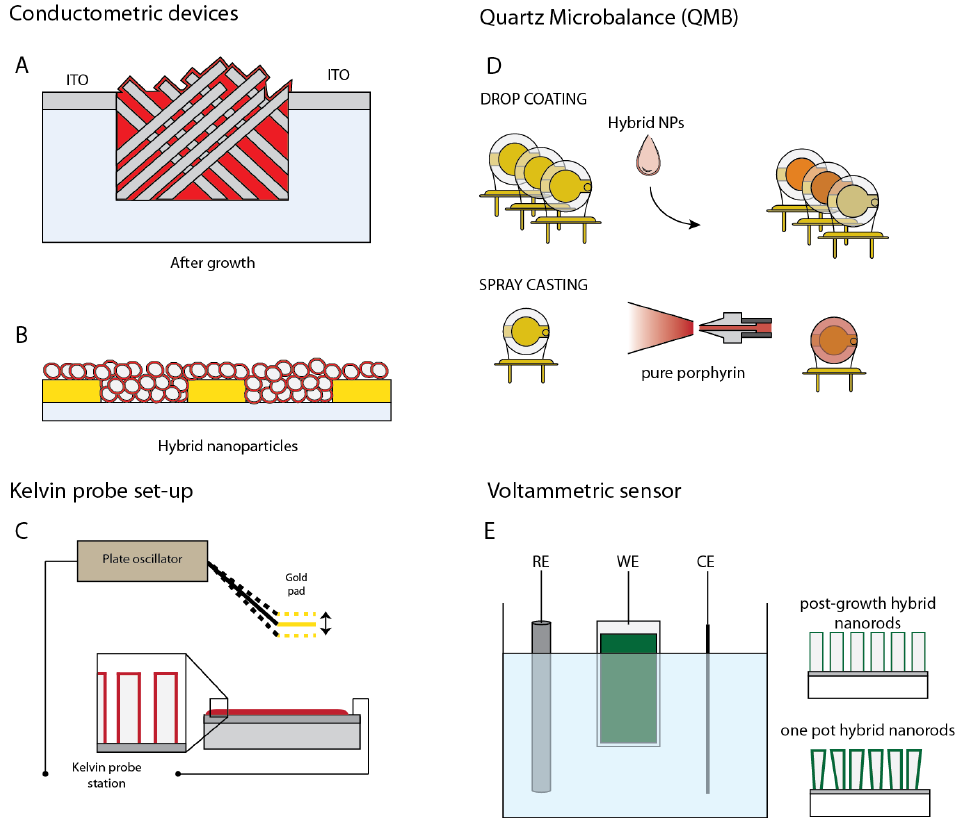
Figure 4. Different gas sensor configurations: ( A ) conductometric based on nanorods; Different gas sensor configurations: ( A ) conductometric based on ( B ) conductometric based on nanoparticles; ( C ) Kelvin probe applied to both nanorods and nanoparticles; ( D ) quartz microbalances coated with nanoparticles (NPs); ( E ) voltammetric set-up for